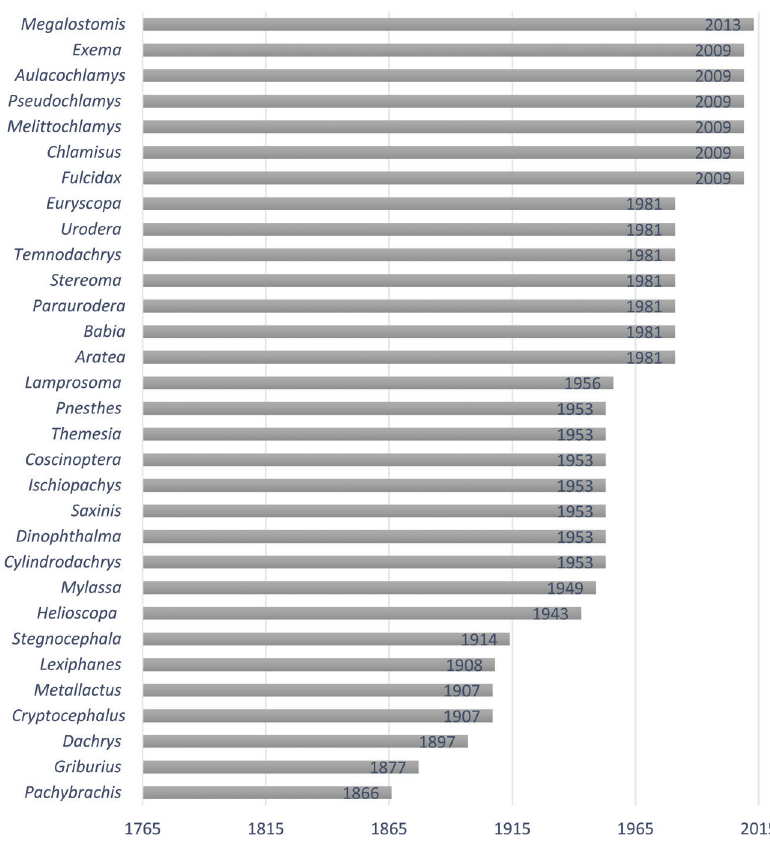
Figure 39. Timelines showing the years of the last work made on each genera that includes Argentinian species taxonomic treatment (simple checklist